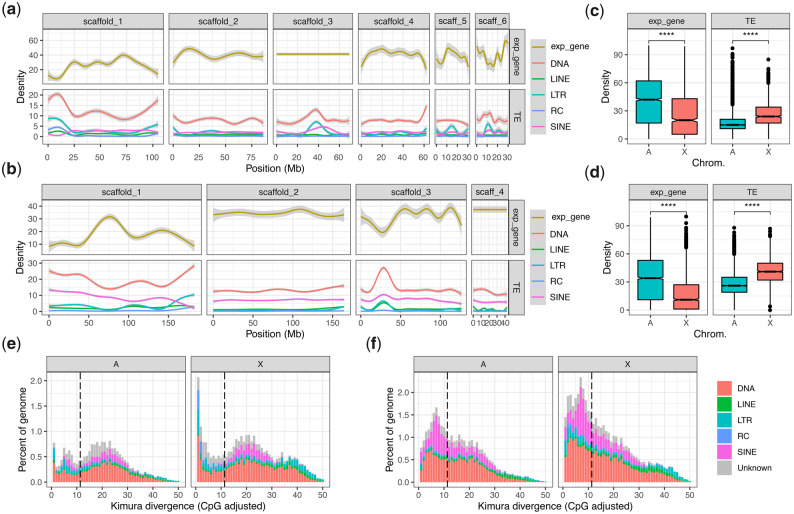
The aphid X chromosome is repetitive and depleted in expressed genes. (a) The density of expressed genes (expr_gene) and TEs across Myzus persicae clone O v2 chromosome-length scaffolds. Genes were classified as expressed if they had an estimated read count >4 in at least 12/24 M. persicae morph RNA-seq samples (see fig. 6). Lines show LOESS smoothed averages of 100-kb fixed windows. For detailed plots showing all data points for each feature class, see supplementary figures 14 and 15, Supplementary Material online. DNA, DNA transposons; LINE, long interspersed nuclear element; LTR, long terminal repeat retrotransposons; RC; rolling-circle transposons; SINE, short interspersed nuclear elements. (b) As for (a) but showing TEs and expressed genes across ApisJIC1 chromosome-length scaffolds. Genes were classified as expressed if they had an estimated read count >4 in at least 3/6 Acyrthosiphon pisum morph RNA-seq samples from Jaquiéry et al. (2013). (c) Box plots showing median density of expressed genes and TEs in 100-kb fixed windows across M. persicae autosomes and the X chromosome. The X chromosome has significantly lower gene density (Wilcoxon rank-sum test: W = 1,934,963, P < 2.2 × 10−16) and significantly higher TE density (Wilcoxon rank-sum test: W = 786,210, P < 2.2 × 10−16) than the autosomes. (d) Box plots showing median density of expressed genes and TEs in 100-kb fixed windows across A. pisum clone JIC1 autosomes and the X chromosome. The X chromosome has significantly lower gene density (Wilcoxon rank-sum test: W = 16,062,992, P < 2.2 × 10−16) and significantly higher TE density (Wilcoxon rank-sum test: W = 6,340,780, P < 2.2 × 10−16) than the autosomes. (e) Stacked histograms showing the age distribution of TEs located on M. persicae clone O autosomes (A) and the X chromosome (X). TE families are grouped as for (a) and (b). The dashed black line indicates half the median synonymous site divergence (11.35%) between M. persicae and A. pisum one-to-one orthologs and is a proxy for the divergence time, that is, TE insertions with lower divergence from their respective consensus sequence than this point likely arose after M. persicae and A. pisum diverged. (f) As for (e) but for A. pisum clone JIC1.